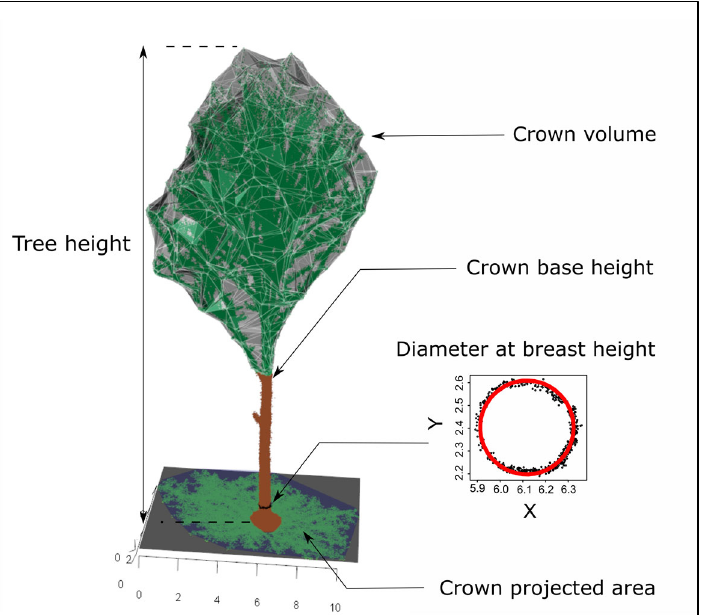
Figure 5. Tree structural attributes estimation from a MLS tree: tree height (H), crown base height (CBH), crown projected area (CPA), crown volume (CV), and diameter at breast height (DBH), estimated from a 5 cm slice of the stem at 1.3 m above the ground.